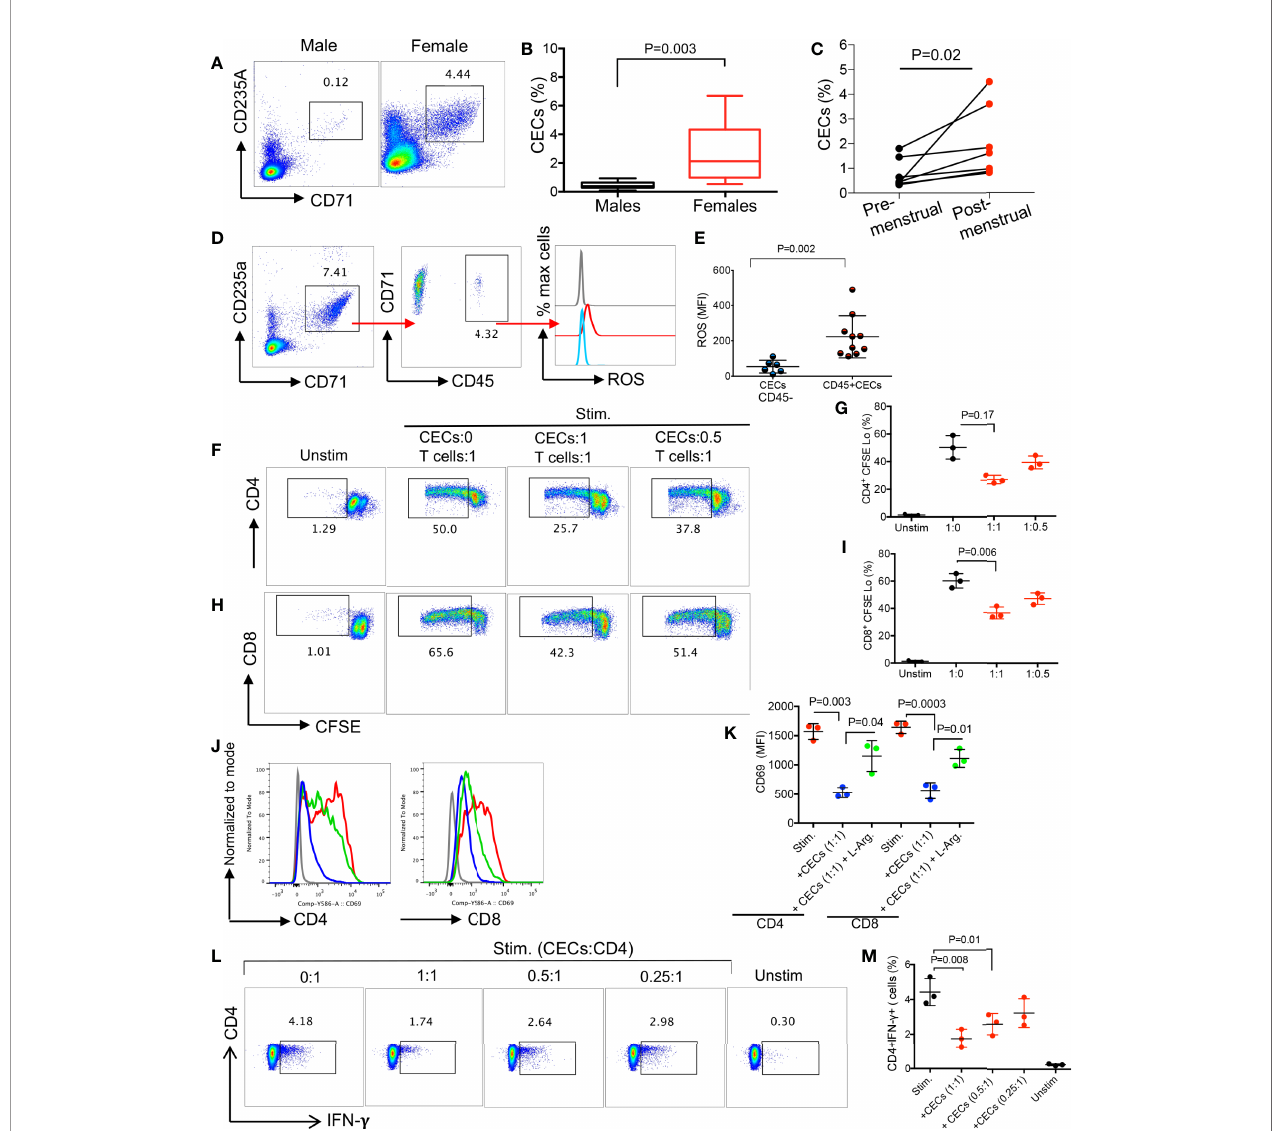
FIGURE 5 | CECs are more abundant in human females and suppress T cell activation and IFN- g production. (A) Representative fl ow cytometry plots, and (B) cumulative data of percentages of CECs in males versus females (>15 subjects/group). (C) Cumulative data of % CECs in females pre-and post-menstrual cycle. (D) Representative fl ow cytometry plots of percent CD45+ subpopulation and ROS expression in CECs. (E) Cumulative data of MFI for ROS expression in CD45 − and CD45+ CECs in women. (F) Representative fl ow cytometry plots, and (G) cumulative data of CD4+ T cell proliferation as measured by CFSE dilution in the absence or presence of CECs at indicated ratios following stimulation with anti-CD3/CD28 for 3 days. (H) Representative fl ow cytometry plots, and (I) cumulative data of CD8+ T cell proliferation in the absence or presence of CECs at indicated ratios following stimulation with anti-CD3/CD28 for 3 days. (J) Histogram plots, and (K) cumulative data of CD69 expression on CD4+ and CD8+ T cells in the absence or presence (1:1 ratio) of CECs following stimulation with anti-CD3/CD28 for 24 h with or without supplementation with L-arginine (2 mM) in females. (L) Representative fl ow plots, and (M) cumulative data of IFN- g production by CD4+ T cells in the absence or presence of CECs at different ratios (CECs : CD4) after stimulation with anti-CD3/CD28 for 6 h. Unstimulated (Unstim), stimulated with anti-CD3/ CD28 (stim). Each point represents data from an individual woman, data are from three different study subjects. Bar, mean ± standard